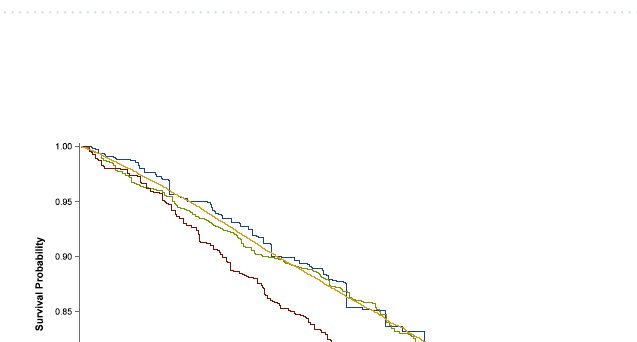
Table 1. Baseline characteristics stratified by depression-related weight change in Ontario adults in the NPHS 1996, CCHS Cycle 1.1, CCHS Cycle 2.1 (n = 59,315). Weighted using survey weights provided by Statistics Canada; all missing covariates imputed. a BMI categories corrected using Gorber’s correction equations. b N = 39,717, excluding participants not asked optional medication module (n = 19,552) or missing information on medication (n = 45).